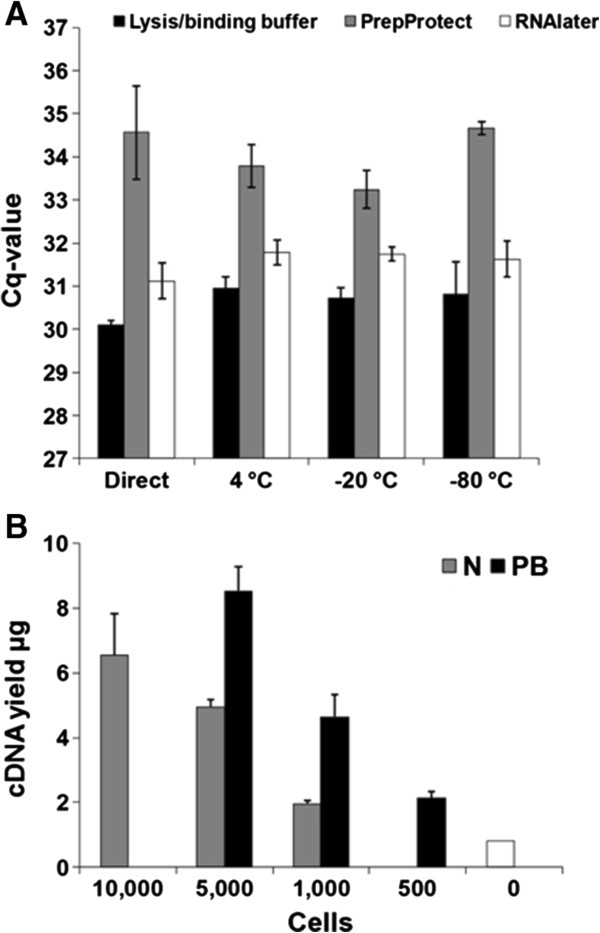
Optimization and performance of the protocol. A: Selection of storage buffer for sorted cells. RNA yield from 15,000 N tonsil cells. The cells were sorted into different storage reagents and mRNA was purified with MBI either immediately after cell sorting or after 14 days of storage at 4°C, -20°C and -80°C. RNA yields were determined by RT-qPCR targeting PPIA. Mean Cq values were calculated from triplicate RNA extractions from each storage reagent. Error bars represent SD (n = 3). B: Amplified cDNA yield from a fixed number of flow sorted N and PB cells derived from a tonsil. The cells were sorted in lysis/binding buffer and mRNA was purified with MBI. Prior to amplification, the mRNA was concentrated by speedVac centrifugation. The amplified cDNA yield was measured on the nanodrop. Error bars represent SD of 3 experiments.